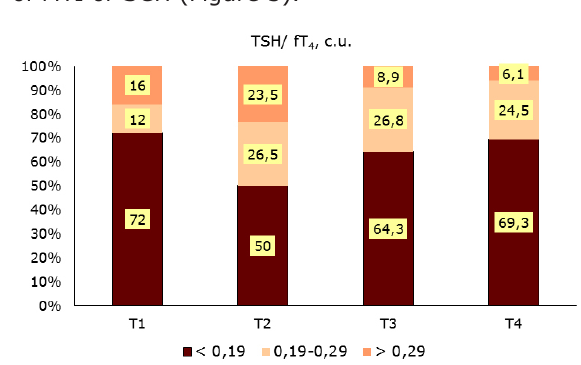
Figure 3. The frequency of TSH/fT tors of different levels in patients with type